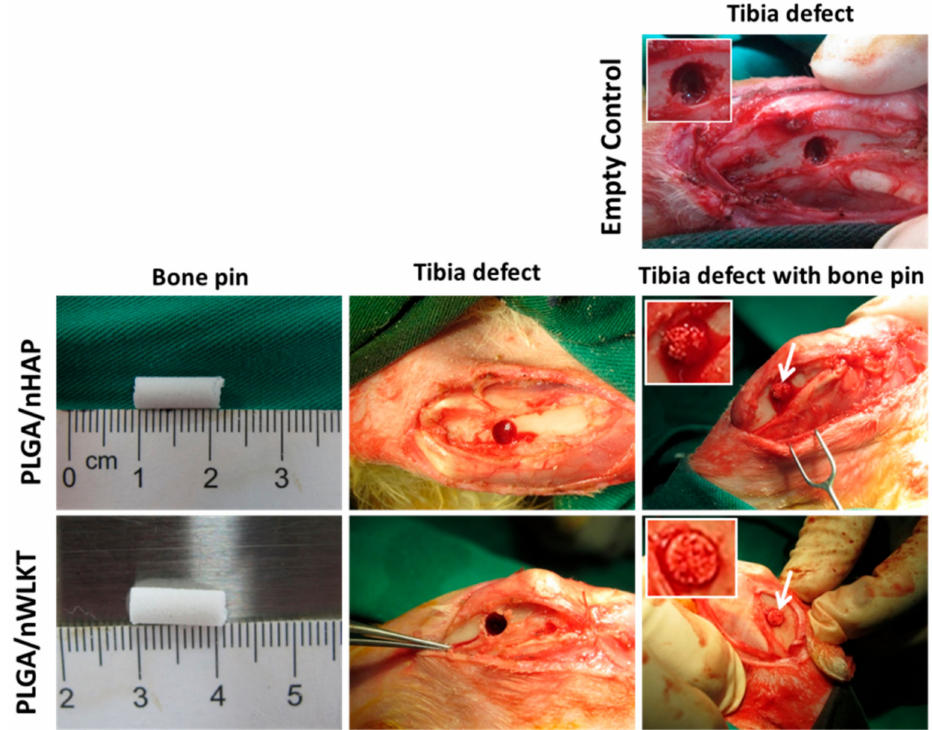
Figure 8. Gross view of the surgical procedure for the implantation of bone pin grafts in rabbit tibia defects. The white arrows denote the implanted bone pine graft. The inserts are enlarged views of the bone